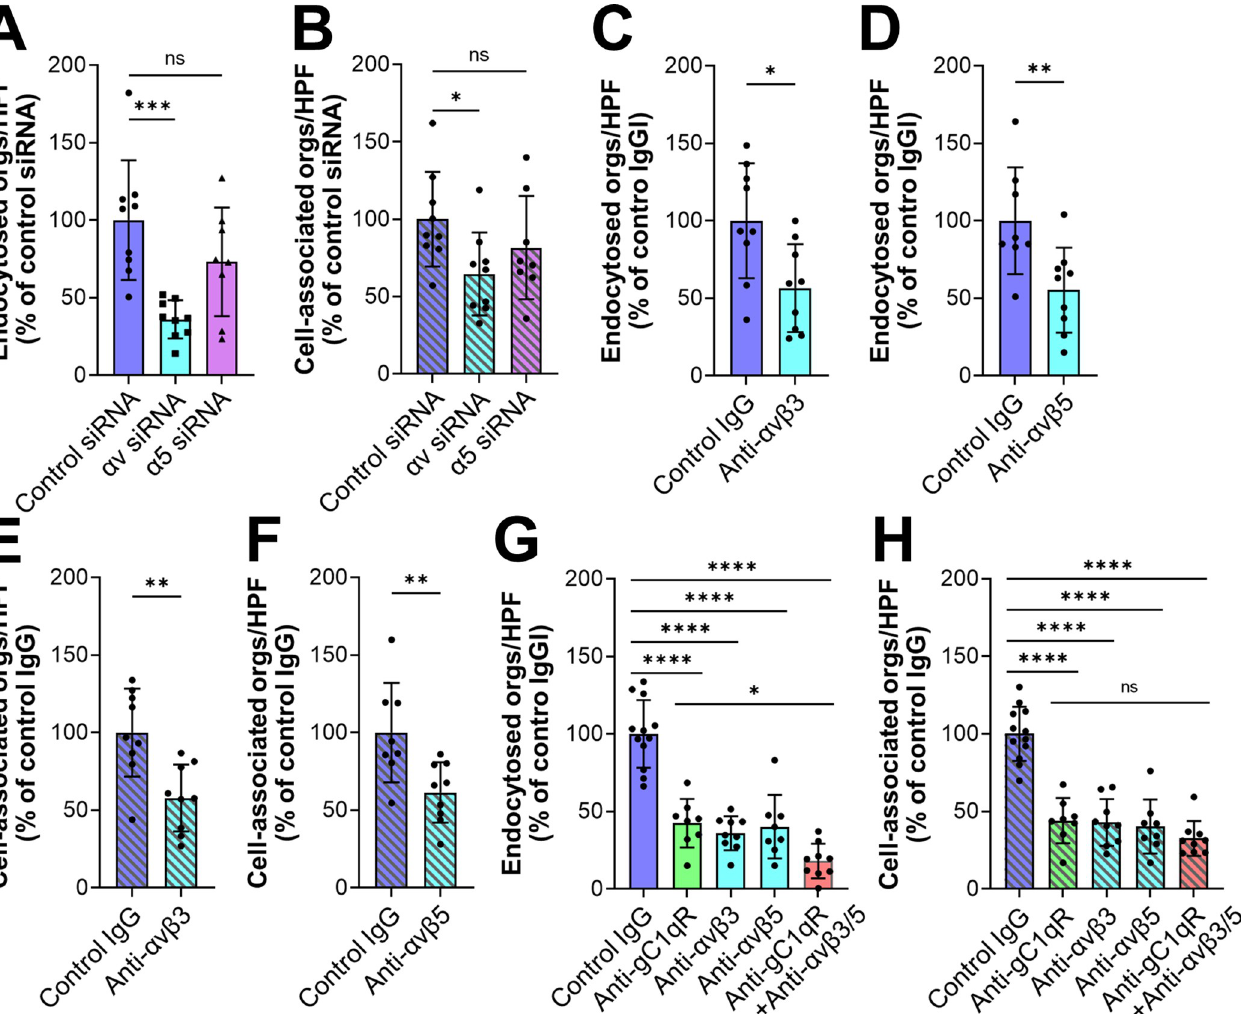
Fig 3. Integrins α v β 3 and α v β 5 are human endothelial cell receptors for serum-coated C . glabrata . (A-F) Effects of inhibiting α v integrin function with siRNA knockdown (A and B or)specific monoclonal antibodies (C-F) and on the endocytosis (A, C, D) and cell-association (B, E, F) of serum-coated C . glabrata . (G and H) Inhibition of gC1qR (with monoclonal antibody 74.5.2) and α v integrins has an additive effect on decreasing the endocytosis (G) but not cell-association of serum-coated C . glabrata (H). Results are the mean ± SD of 3 experiments, each performed in triplicate. Orgs/HPF, organisms per high power field; ns, not significant; � P < 0.05, �� P < 0.01, ��� P < 0.001, ���� P < 0.0001 by ANOVA with the Dunnett’s test for multiple comparisons (A, B, G, H) or the Student’s t-test (C-F).